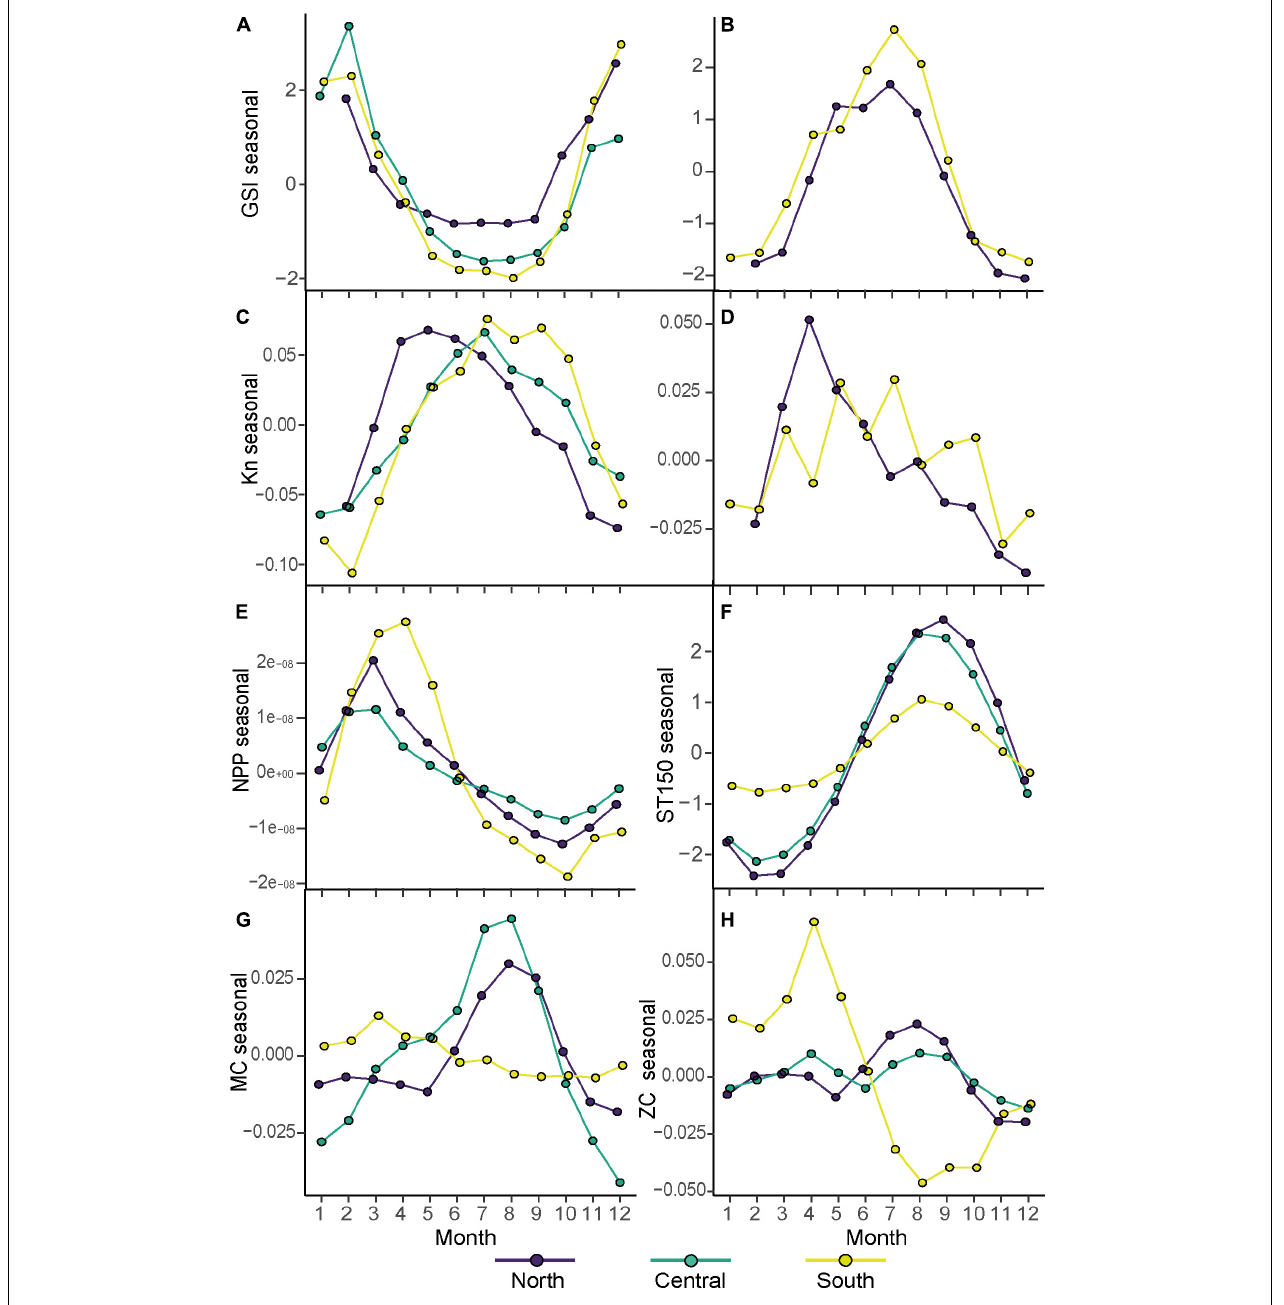
FIGURE 4 | Seasonal component of the detrended time series of the gonadosomatic index (GSI seasonal) and relative condition factor (Kn seasonal) for sardine (A,C) and for anchovy (B,D) . Environmental seasonal components for net primary production (NPP; E ), Sea Temperature at 150 m (ST150m; F ) and the zonal current (ZC; G ) and meridional current (MC; H ). Each color represents an Area (North, Central, and